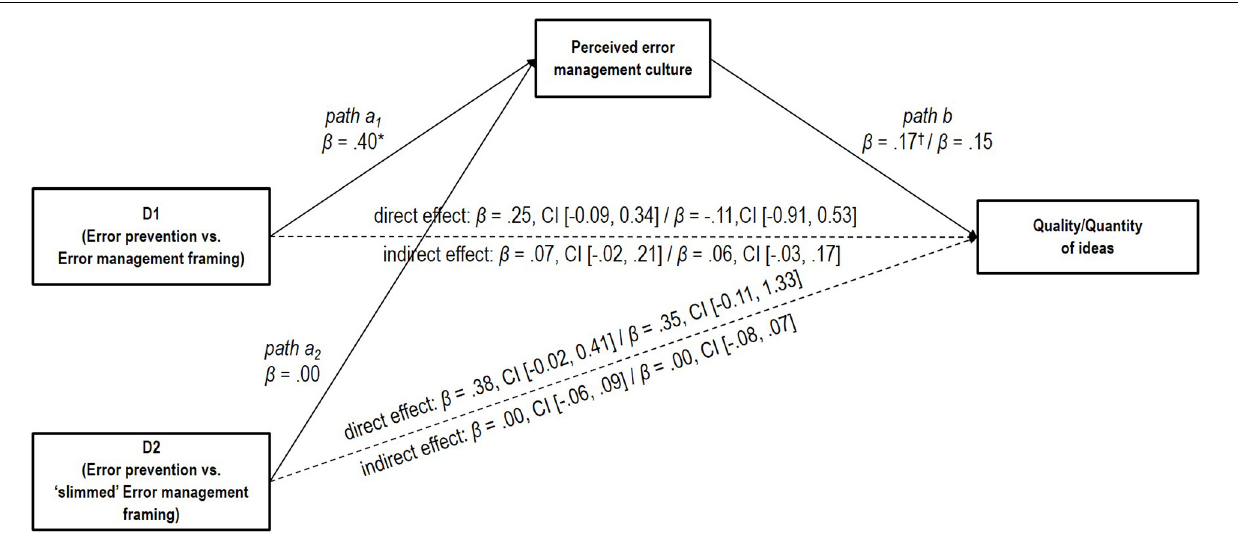
FIGURE 1 | Original mediation model in Study 2. The non-significant indirect effect of dummy variable D1 for our manipulation [i.e., error prevention (coded 0) vs. error management framing (coded 1)] and the non-significant indirect effect of dummy variable D2 for our manipulation [i.e., error prevention (coded 0) vs. “slimmed” error management framing (coded 1)] on performance (quality or quantity of ideas) through perceived error management culture in Study 2. The dashed arrows indicate the direct paths between the dummy variables for our manipulation (D1 and D2) and performance. Standardized and partially standardized values and confidence intervals (CI). N = 128 teams, † p < 0.10, * p <